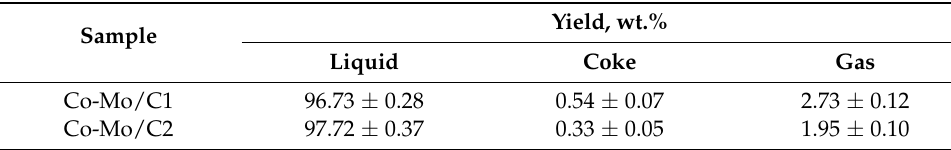
Table 7. Material balance for upgrading processes.